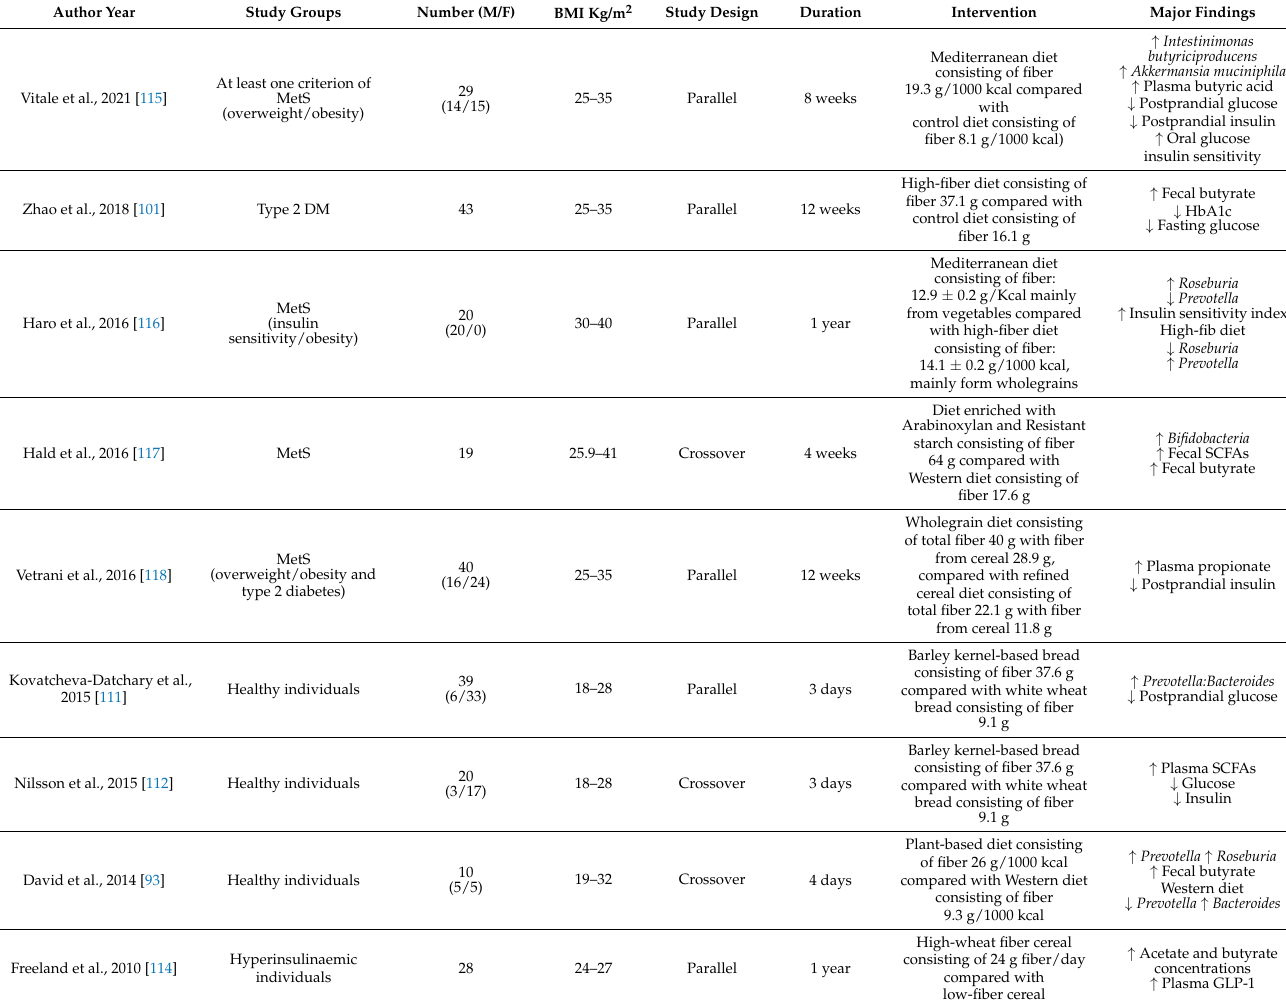
Table 6. Randomized clinical trials pointing to the role of SCFAs in the maintenance of glucose homeostasis, in metabolic syndrome, and in type 2